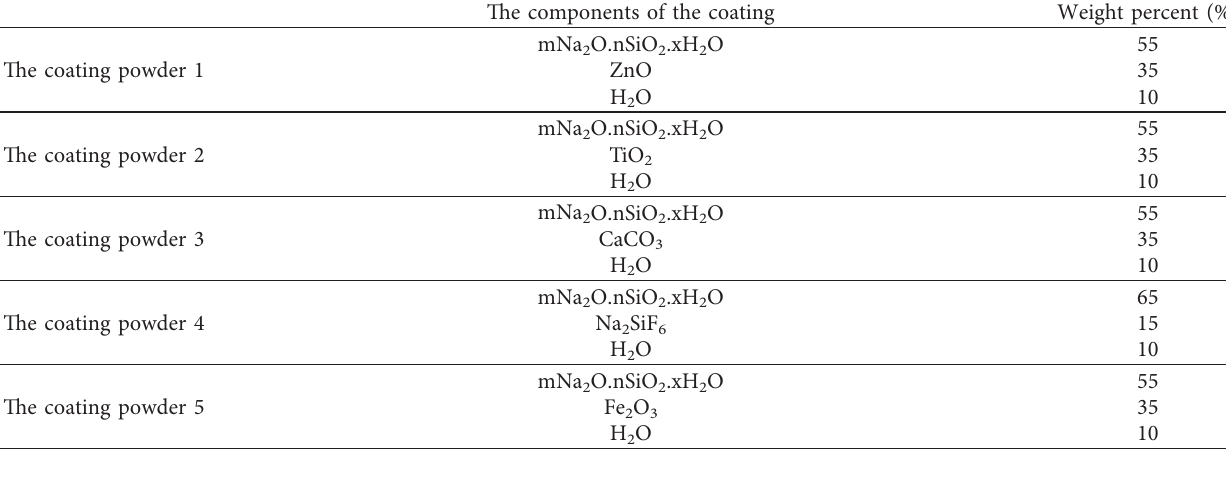
Table 1: The components of the mixture of liquid sodium glass with each of the extender pigments (ZnO, TiO Na 2 SiF 6 ).